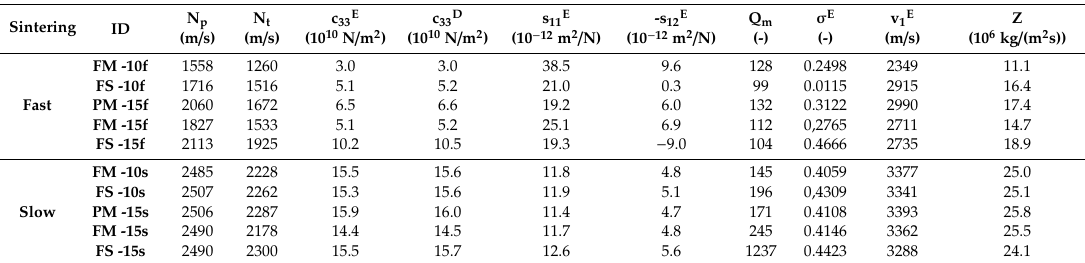
Table 3. Frequency constants in the planar and thickness modes (N p , N t ), mechanical sti ff nesses c 33E and c 33D , mechanical compliances s 11E and s 12E , mechanical quality factor Q m , planar Poisson ratio σ E , acoustic wave velocity v 1E and acoustic impedance Z.